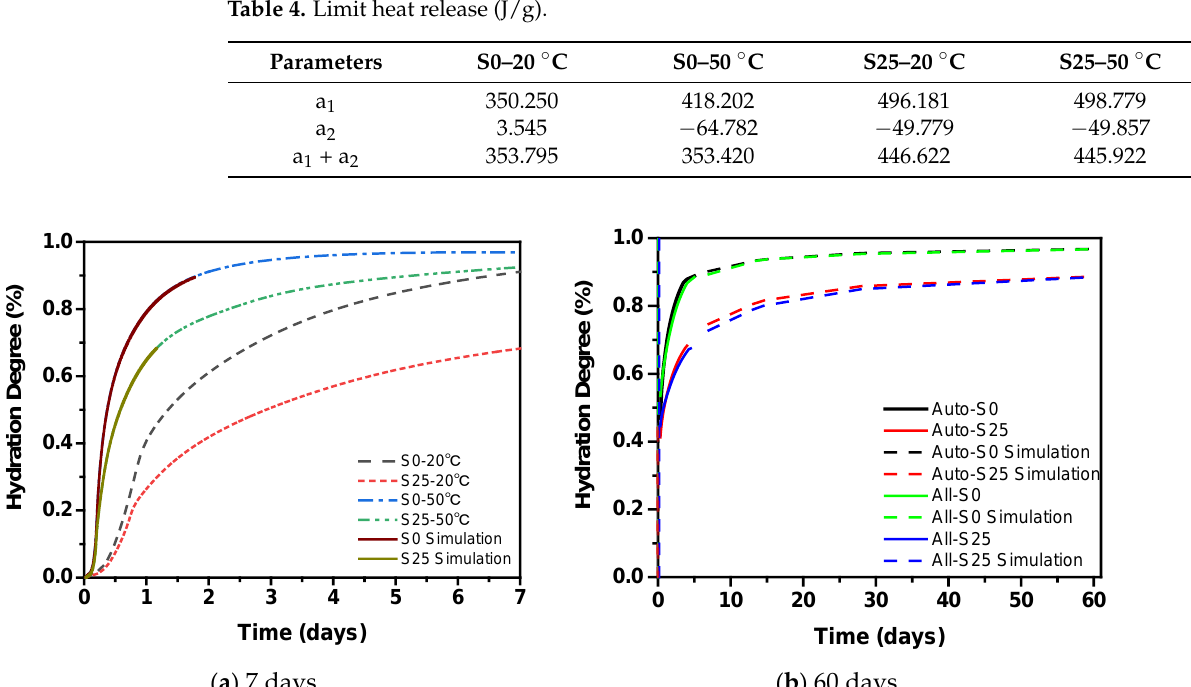
Figure 16. The hydration degree of steam-cured cement paste.